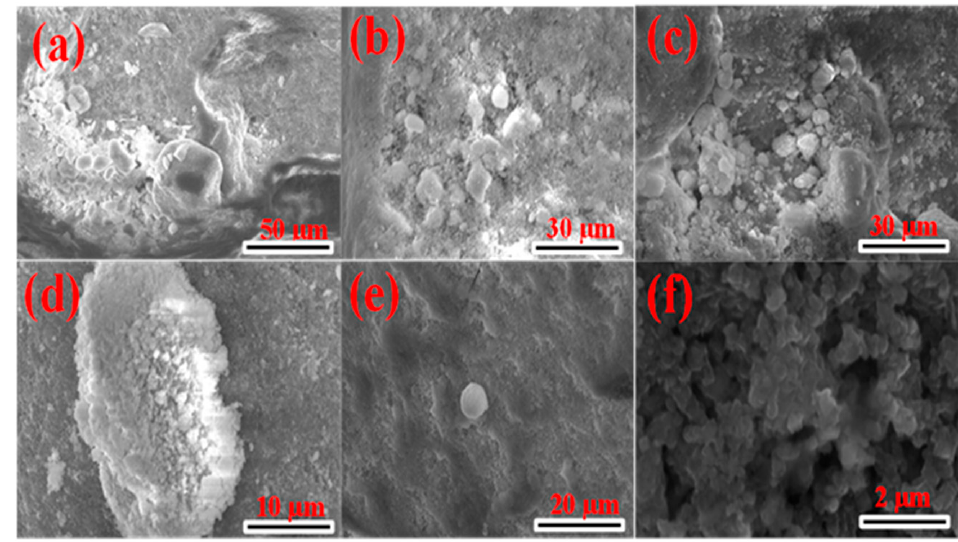
Figure 8. SEM images of Cu x S y nanoparticles prepared in ( a , d ) OLA, ( b , e ) HDA, and ( c , f ) DDA at 190 °C using the complexes 1 and 2.